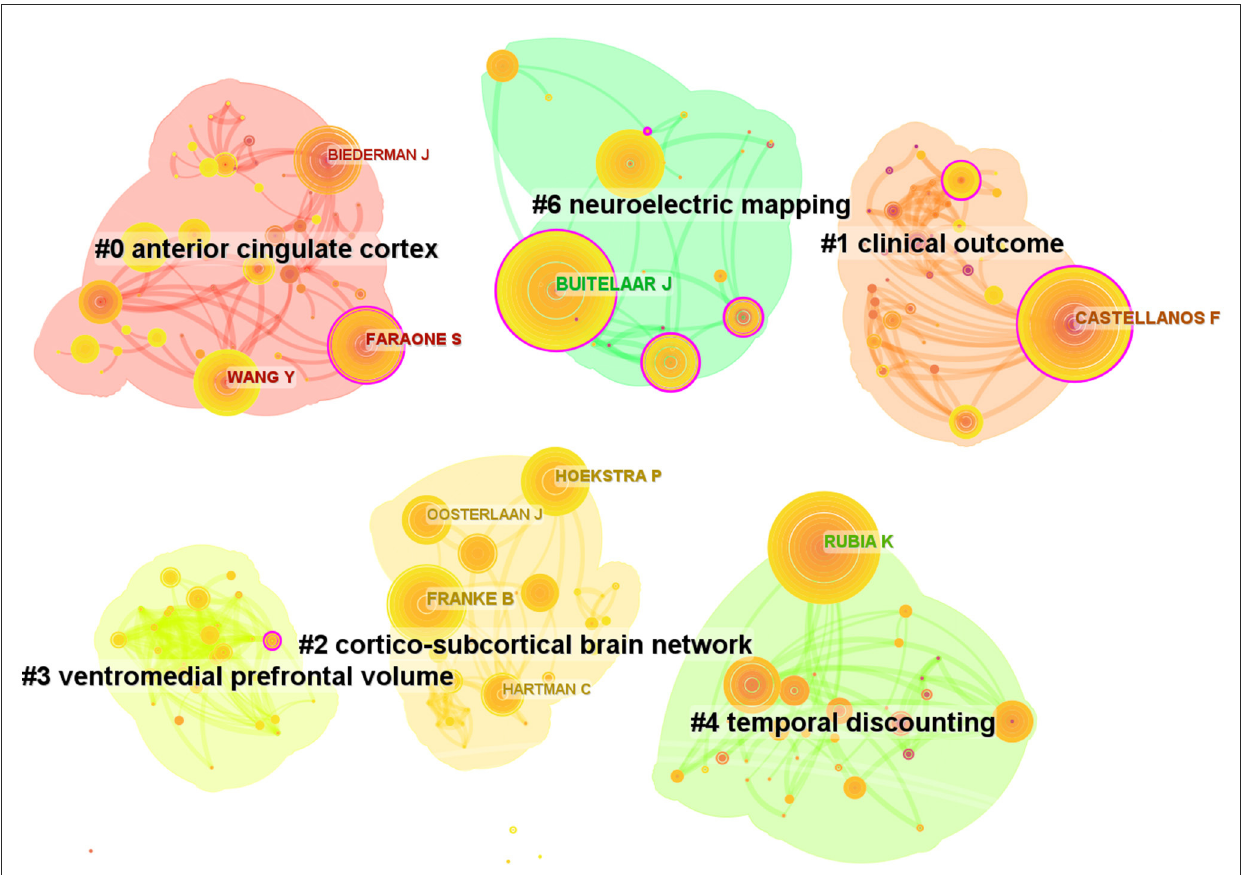
FIGURE6 Map of authors related to ADHD neuroimaging from 1992 to 2022.